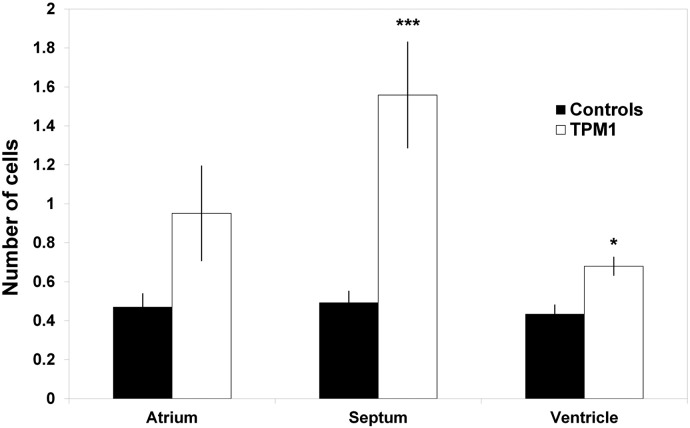
Apoptosis increased in the atrial septum and ventricular wall of TPM1-MO hearts.Apoptosis was measured in UT, SC (pooled as controls; n = 6) and TPM1-MO hearts (n = 7). Apoptosis was significantly increased in the atrial septum and ventricles of TPM1-MO hearts, *P < 0.05 ***P < 0.001.